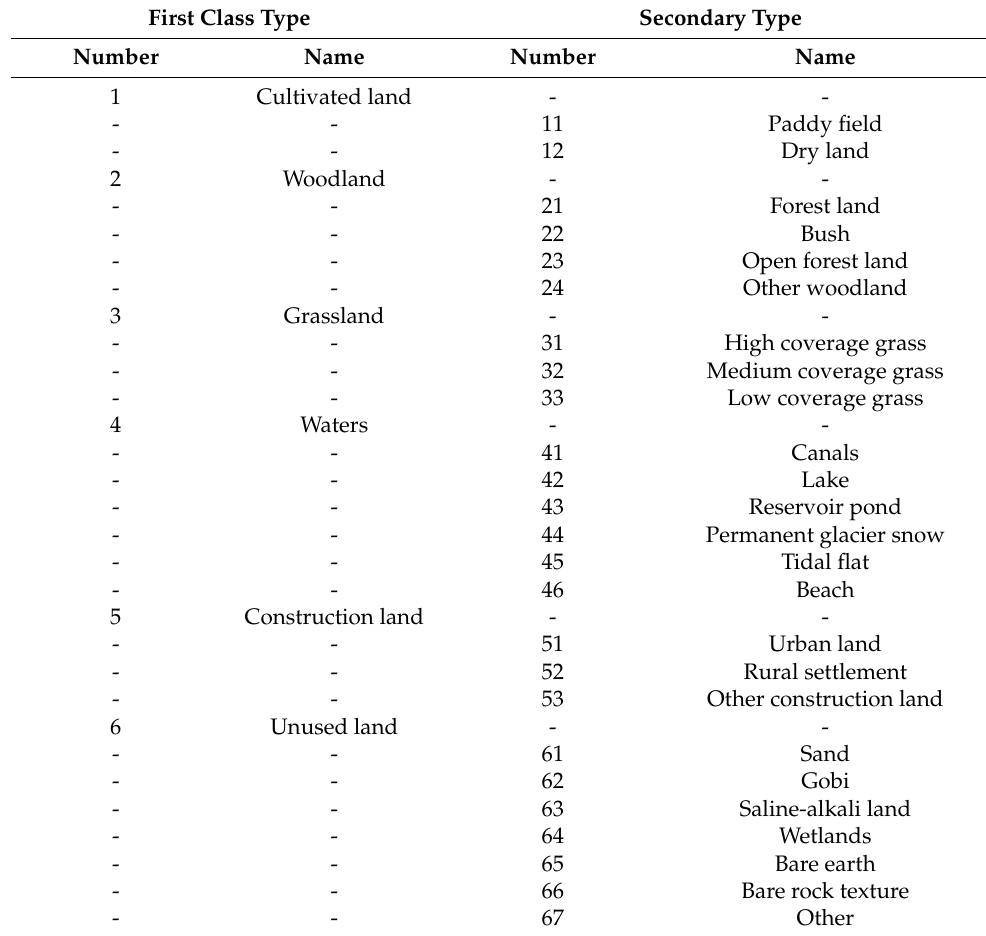
Table A1. National Land Use Classification